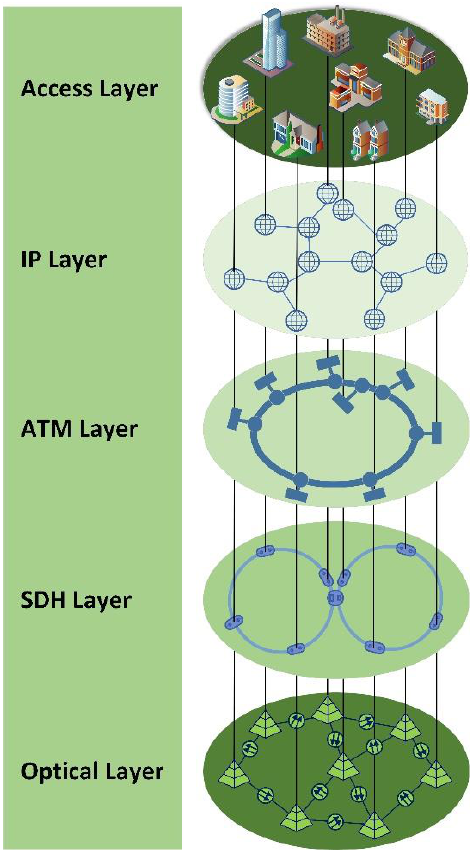
Figure 24. F3G network layered architecture. The fourth generation ( “ F4G ” ) of backbone transport networks was marked by the emergence of advanced optical transport networks (OTNs) which incorporated advanced optical switching features, alongside the multi-protocol label switching (MPLS) approach,